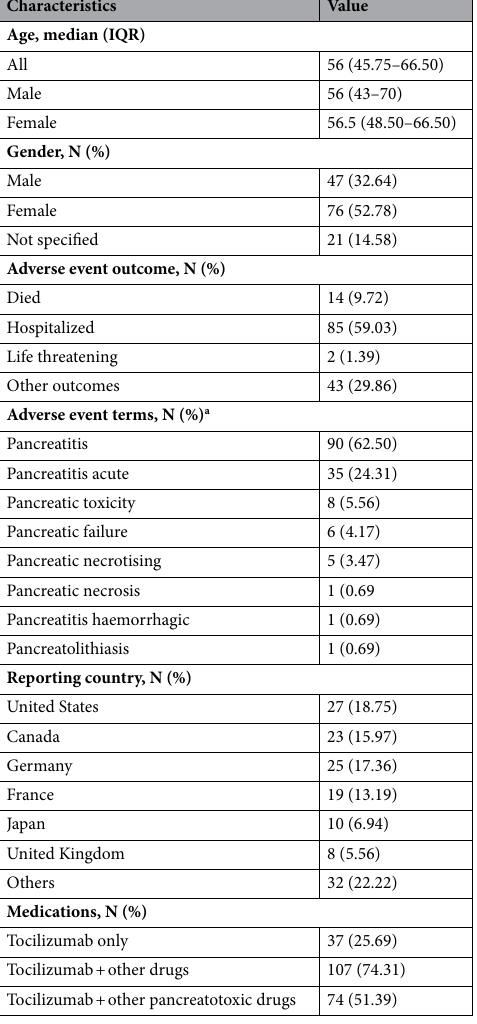
Table 1. Characteristics of cases with pancreatic adverse events following tocilizumab use. a Total count exceeds 144 since three reports contained two adverse event terms each.